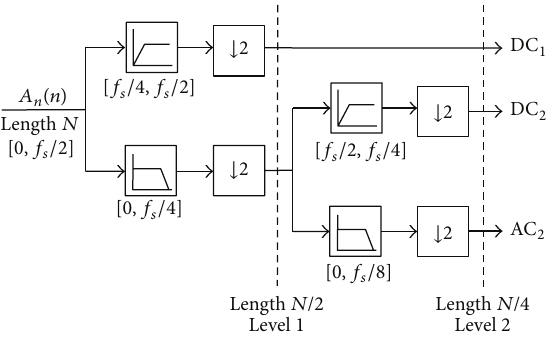
Figure 1: Mallat algorithm for DWT